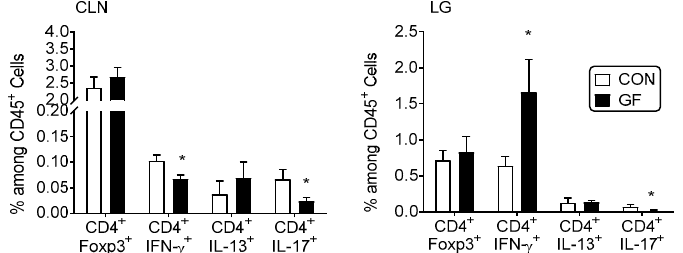
Figure 3. Increased percentage of Th1 + cells in lacrimal gland of germ-free mice. Percentage of CD4 + Foxp3 + , Th1 (CD4 + IFN- γ + ), Th2 (CD4 + IL-13 + ), Th17 (CD4 + IL-17 + ) cells in freshly isolated cervical lymph nodes (CLN) and lacrimal glands (LG) by flow cytometry. Each experiment group consisted of three-to-four samples; showing mean ± SEM of two independent experiments (final n = seven to eight per group). CLN of the same animal were pooled; right and left extraorbital LGs of the same animal were pooled. * p < 0.05 conventional vs. germ-free comparison using Mann-Whitney U test.